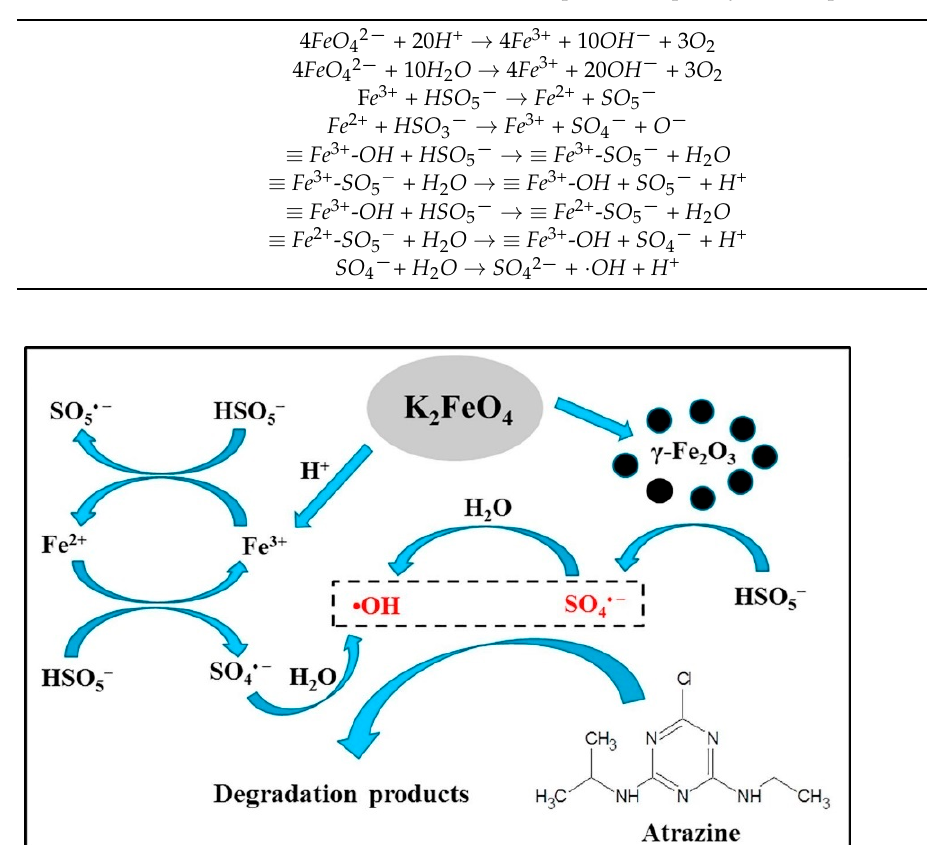
Figure 2 . The schematic of interaction between the ferrate and peroxymonosulfate resultant radicals (redraw from [16]).